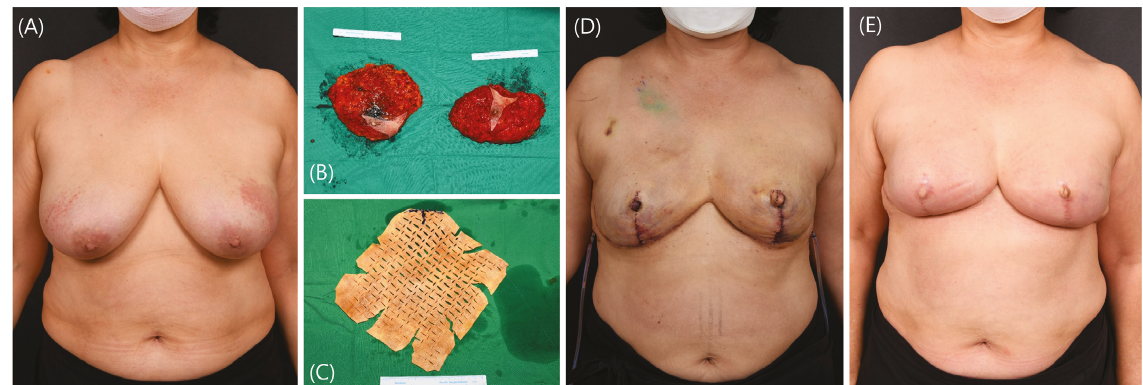
Figure 9: Implant-based breast reconstruction after skin-sparing mastectomy. A patient with bilateral breast cancer underwent bilateral skin-sparing mastectomy followed by bilateral reduction mammoplasty. Megaderm (L&C BIO Inc., Seoul, Korea) (20 × 20cm, 1.5–2mm thick) was covered on a prepectoral plane-breast silicone implant using the anterior coverage technique. (a) Preoperative image. (b, c) The excised masses and acellular dermal matrix (ADM) are shown intraoperatively. (d) Three days postoperative image. (e) Eight months postoperative